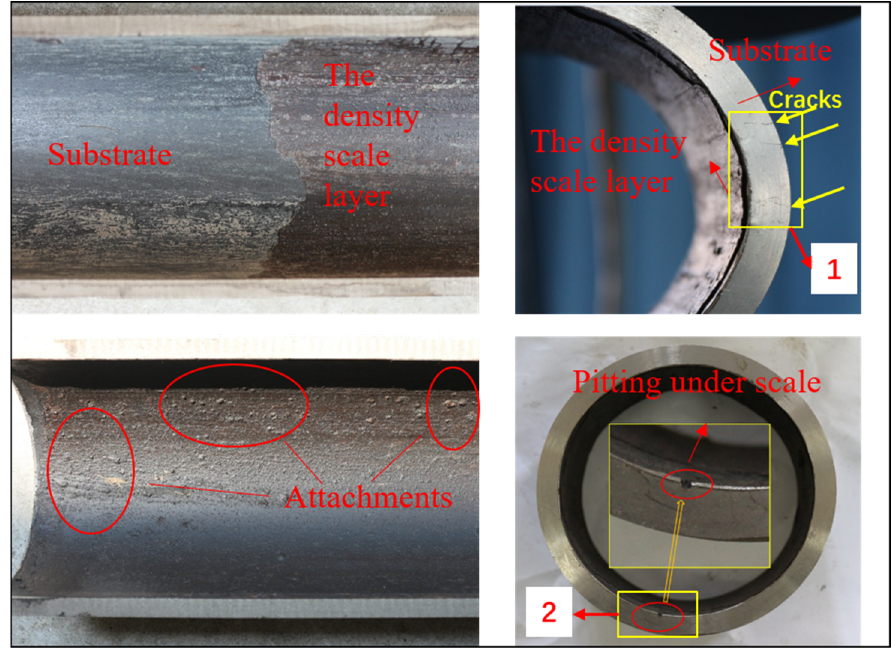
Figure 3. Corrosion Morphology of Failed Tubing in Well X and Schematic Diagram of Test Sampling Area.